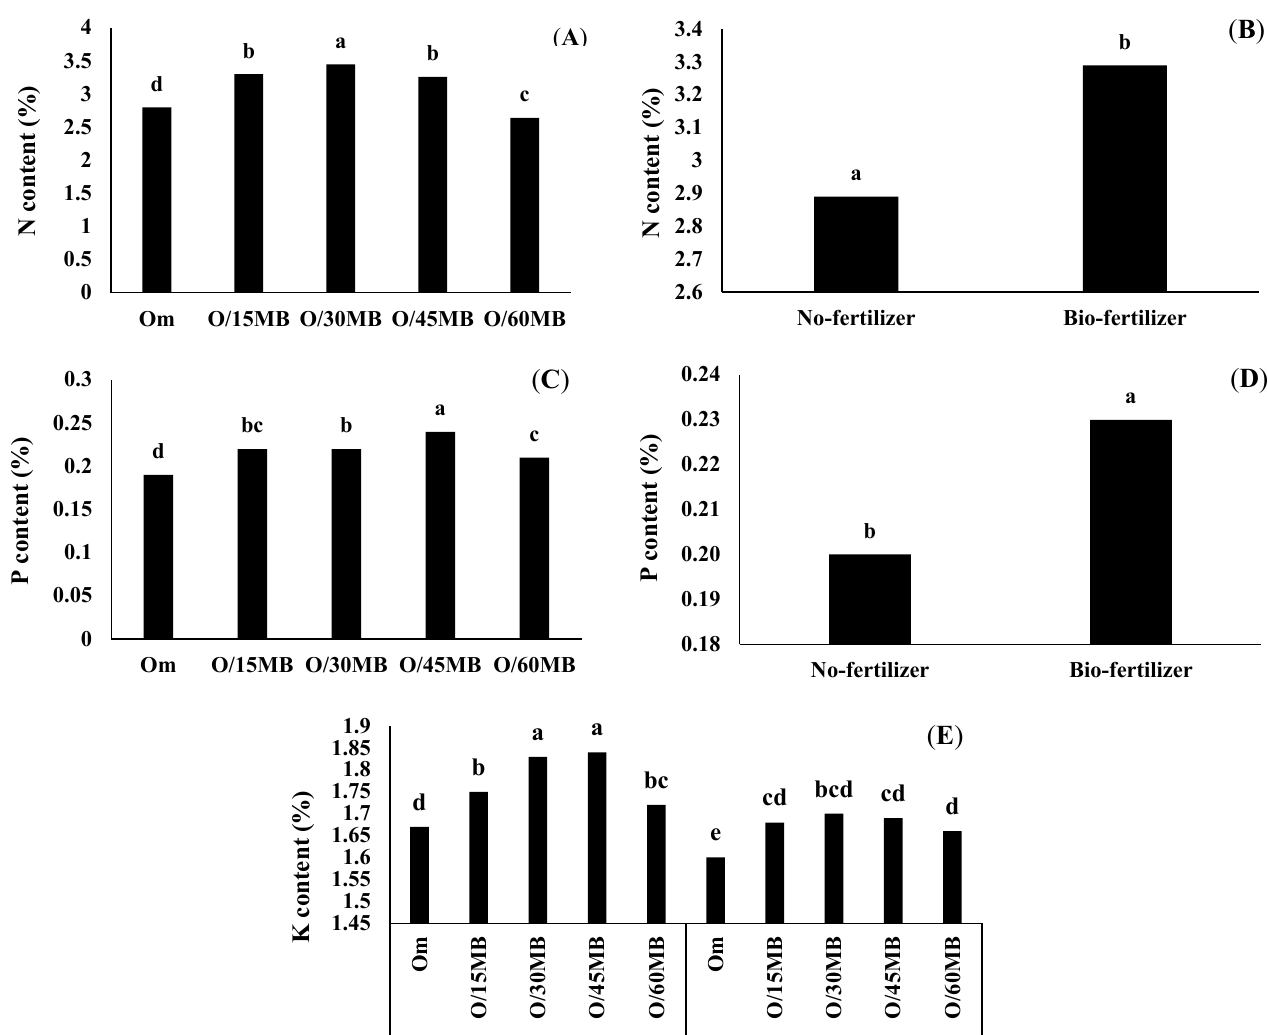
Figure 1. The main effect of cropping patterns ( A , C ) and fertilizer application on N and P content ( B , D ) and interaction effects of two mentioned factors on the K content of marjoram ( E ). Om: marjoram monocropping; O/15MB: intercropping ratios of 100% marjoram + 15% mung bean; O/30MB: 100% marjoram + 30% mung bean; O/45MB: 100% marjoram + 45% mung bean; O/60MB: 100% marjoram + 60% mung bean. Different lower-case letters above the bars indicate significant differences. ( p ≤ 0.05)